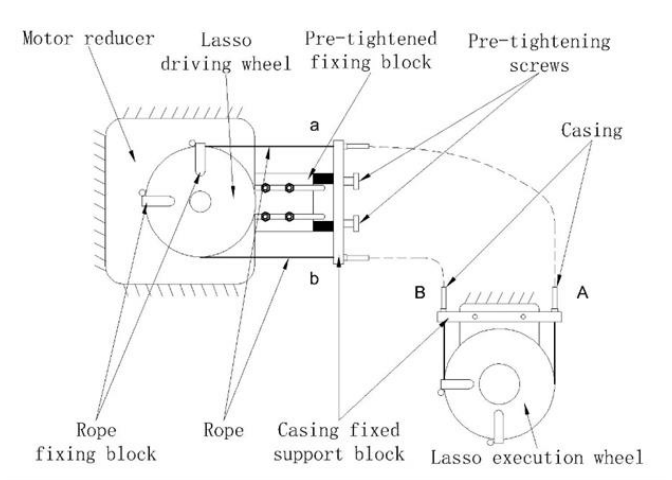
Figure 2. The double-lasso drive mode.